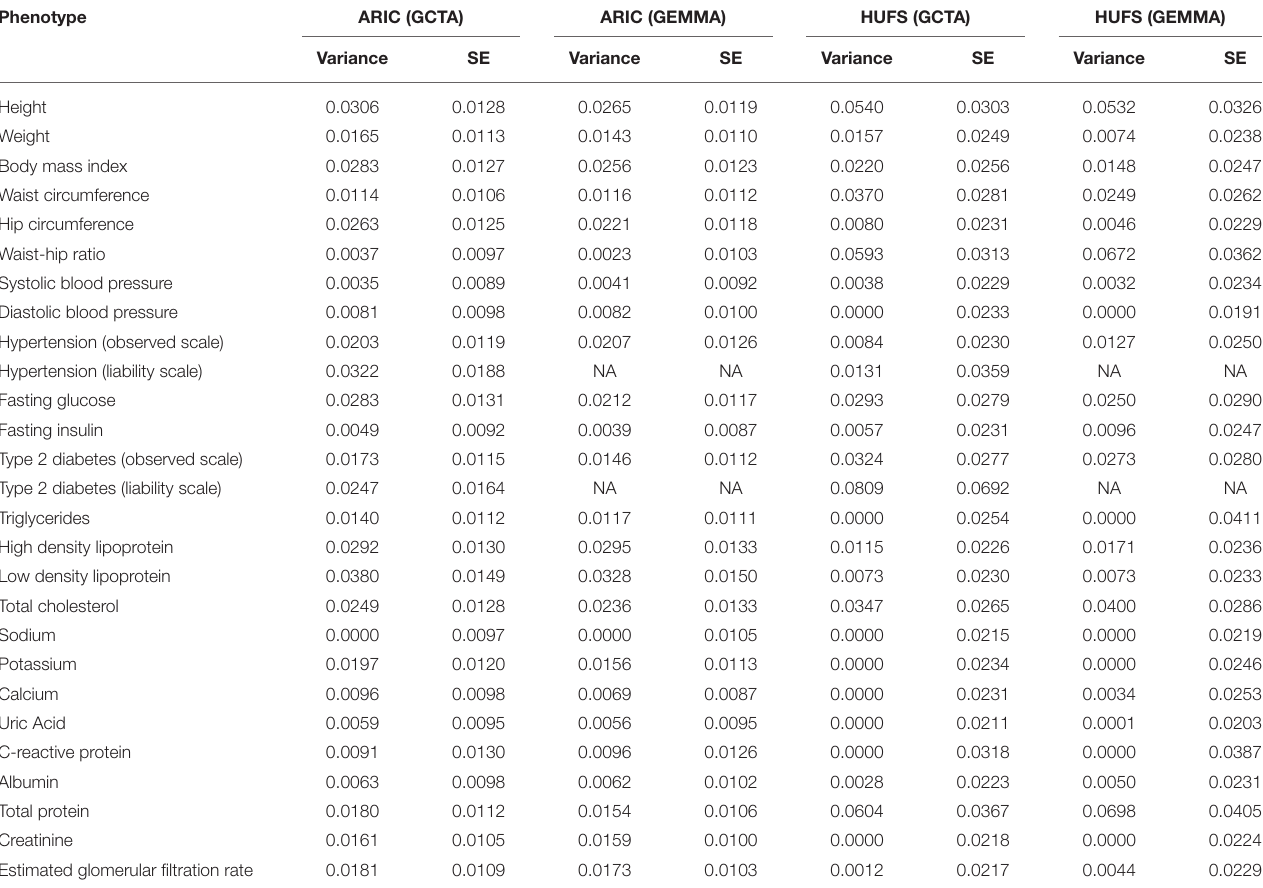
TABLE 3 | Genome-wide proportion of phenotypic variance explained by local ancestry.